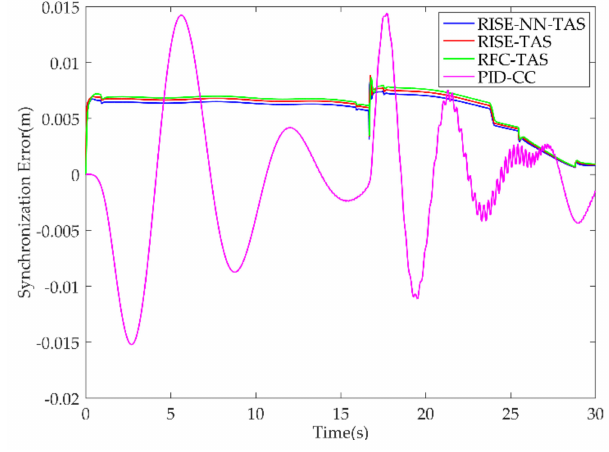
Figure 17. Synchronization errors of the four controllers in case 2. Table 4. Tracking performance indexes of the four controllers in case 2.